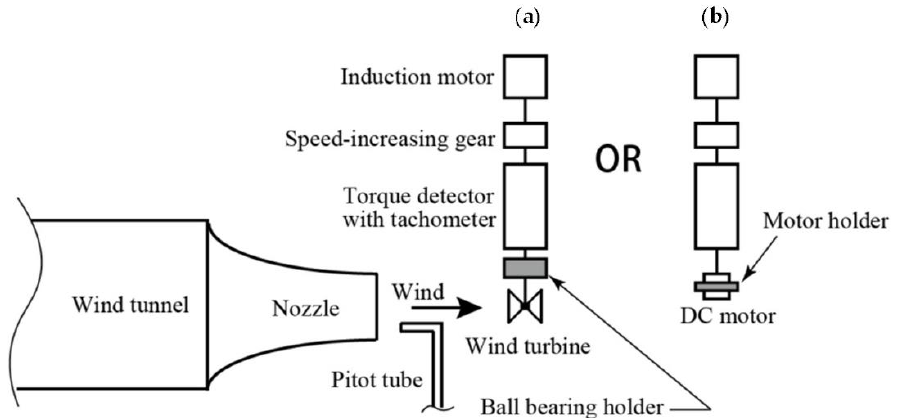
Figure A1. Experimental setup of the torque measurements at Tottori University (viewed from downstream): ( a ) a miniature wind turbine model; ( b ) a direct current motor with no current.